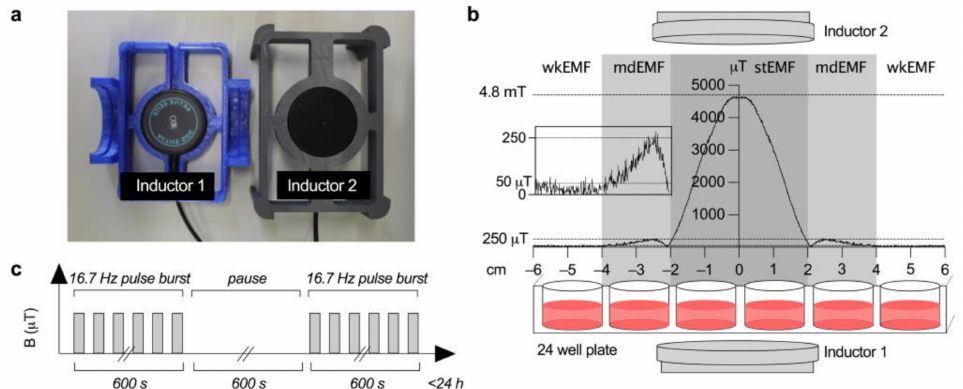
Figure 1. Setup and parameter for EMF exposure. ( a ) Culture plate holder for exact positioning of both inductors towards the sample plate. ( b ) Differences in EMF field strength at the individual sample positions of the culture plate for exposure of wkEMF (<50 µ T), mdEMF (<250 µ T, close up view shown in insert) and stEMF (<4.8 mT). ( c ) A fundamental exposure frequency of 16.7 Hz is applied using a rectangular wave form for up to 24 h with send/pause intervals of 600